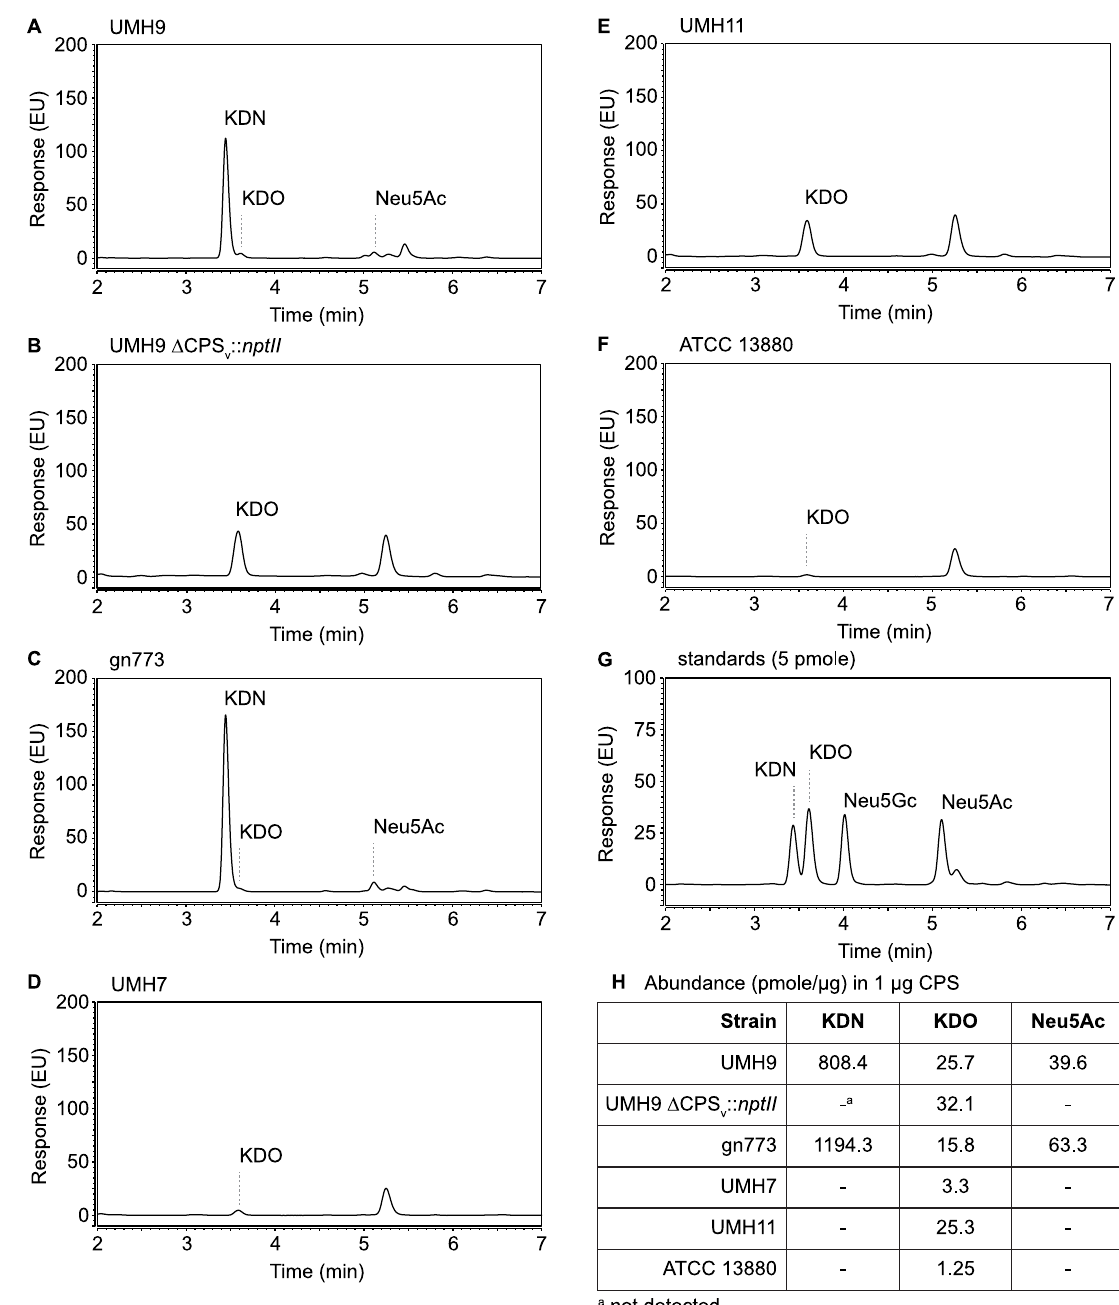
Fig 12. RP-UPLC analysis of sialic acids. (A-F) Polysaccharides were acid hydrolyzed and liberated sialic acids were derivatized with DMB for fluorescence detection following separation by RP-UPLC. (G) RP-UPLC of sialic acid monosaccharide standards (5 pmole). (H) The abundance of selected monosaccharides in each sample was determined based on the standards. Abbreviations: KDN; ketodeoxynonulonic acid; KDO, 3-deoxy-D-manno-octulosonic acid; Neu5Ac, N -acetylneuraminic acid; Neu5Gc, N -glycolylneuraminic